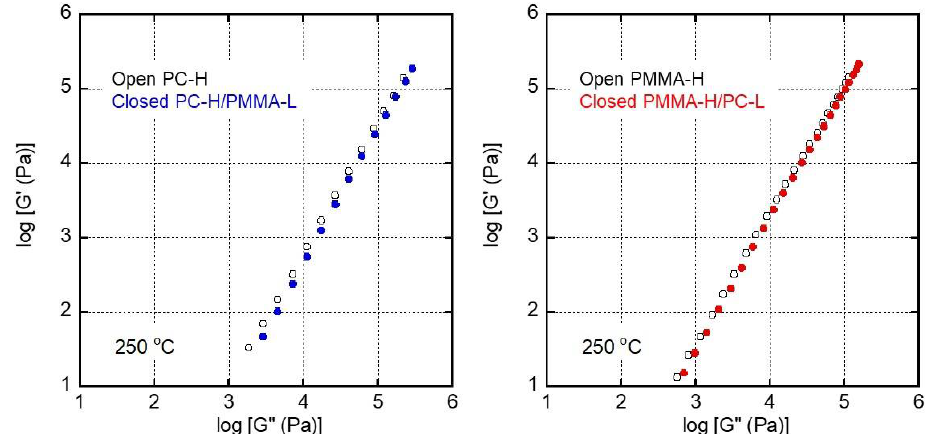
Figure 6. Han’s plot, i.e., the storage modulus G’ plotted as a function of the loss modulus G” , at 250 °C of ( left ) PC-H and PC-H/PMMA-L (90/10) and ( right ) PMMA-H and PMMA-H/PC-L (90/10).